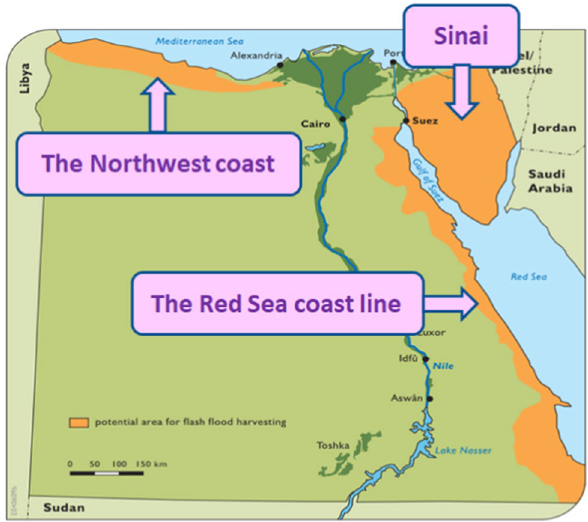
Fig. 2 Potential areas for flash flood harvesting NWEP, National Water Resources Plan 2017